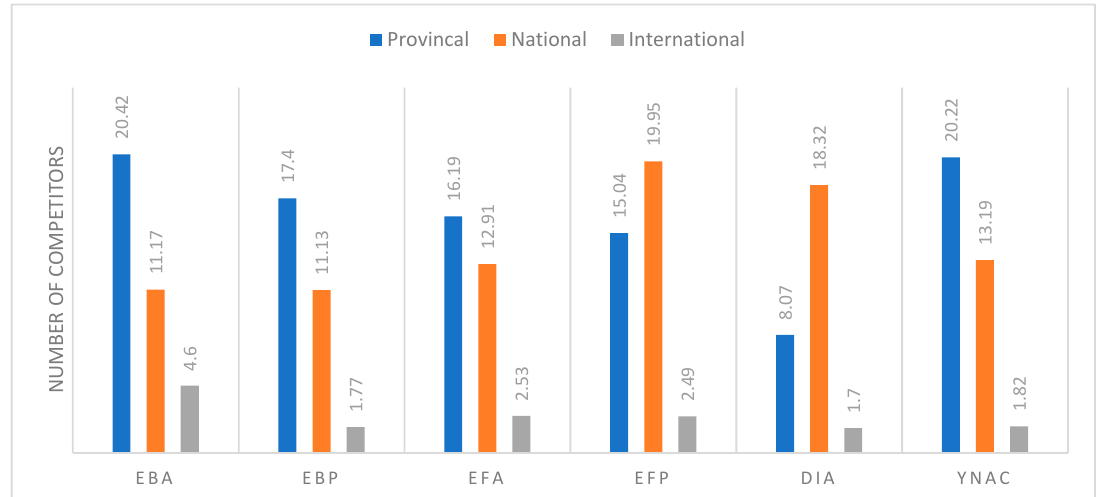
Figure 3. Average number of competitors by YACs and YNACs, 2011–2013. Note: YACs: young adoption companies, YNACs: young non-adoption companies. Technology adoption choices are defined in Table 1. Source: Authors’ calculation from TCS.